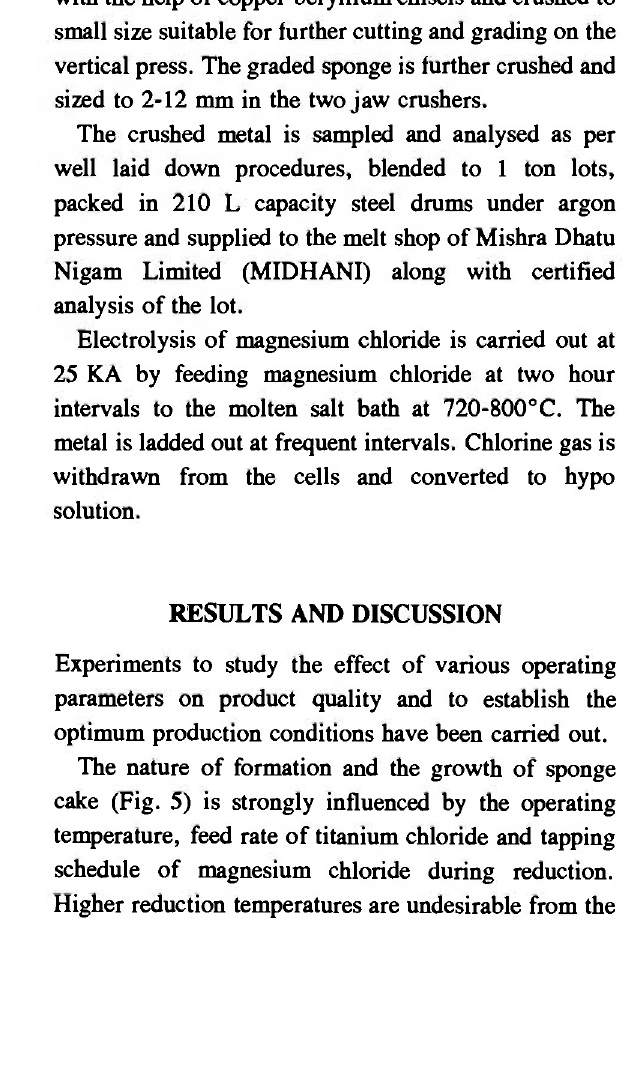
Fig. 4: Mg electrolytic